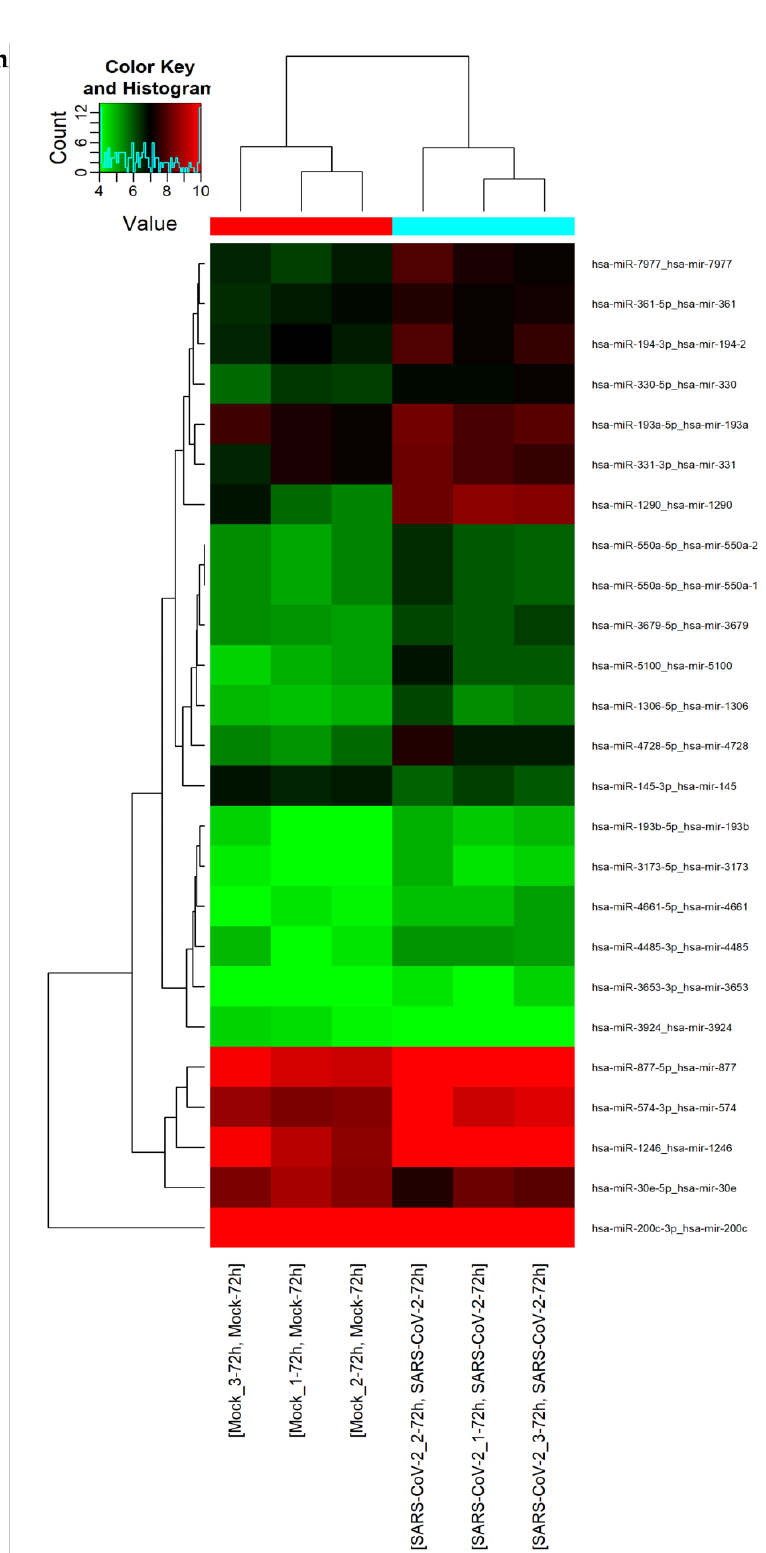
Figure 5. Heat map and hierarchical clustering of differentially expressed miRNAs. miRNA ex- pression levels are illustrated using a histogram and color key. The upper dendrogram illustrates the clustering of samples ( n = 3) infected or not (Mock) with SARS-CoV-2 at ( A ) 24 h and ( B ) 72 h post-infection. The left dendrogram illustrates the clustering of miRNAs differentially expressed and listed in the left vertical axis. Each row represents a miRNA, and each column represents a